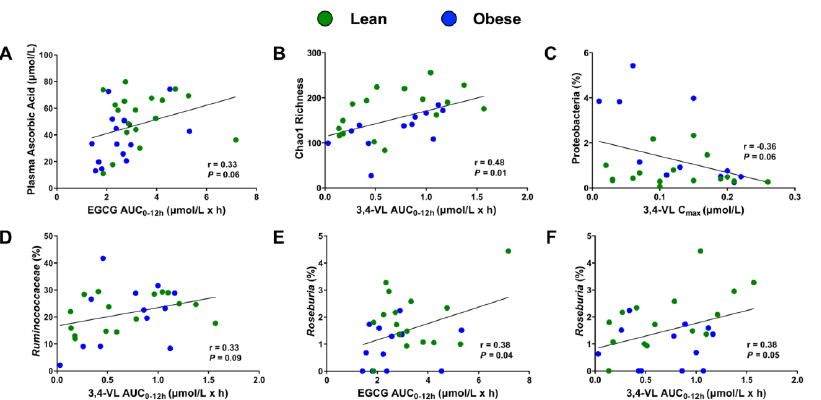
Figure 6. Correlations between A) EGCG bioavailability and ascorbic acid, B) 3,4-VL bioavailability and Chao1 richness, and C-F) EGCG or 3,4-VL pharmacokinetic parameters with relative abun- dances of select taxa in lean and obese persons who completed a pharmacokinetic trial examining green tea catechin bioavailability. Pearson correlation coefficients were calculated by linear